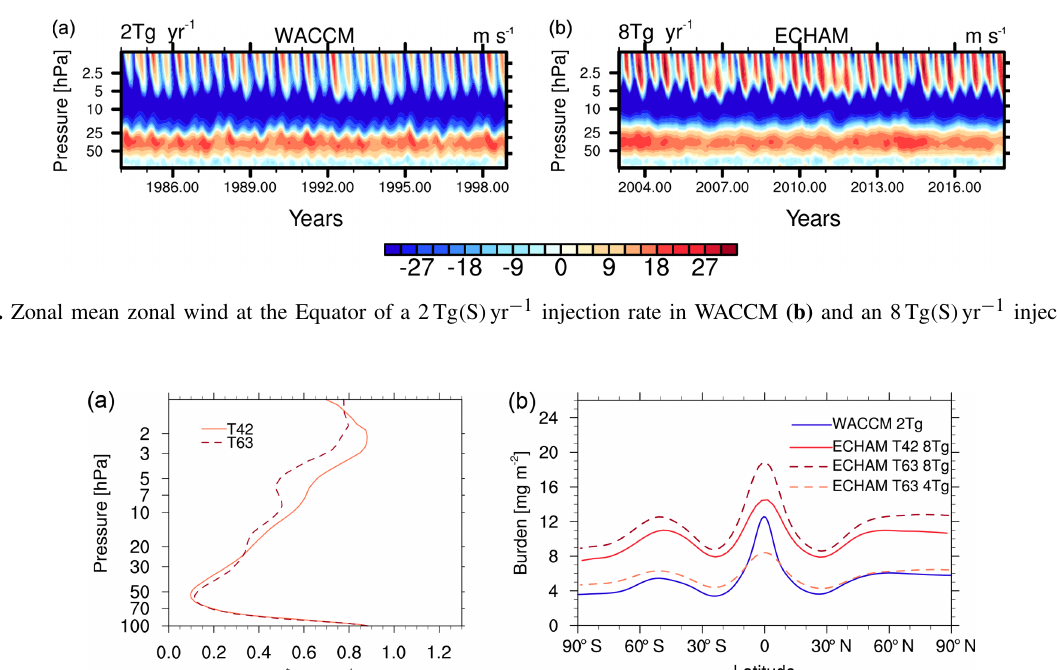
The vertical resolution of the models differs as well: